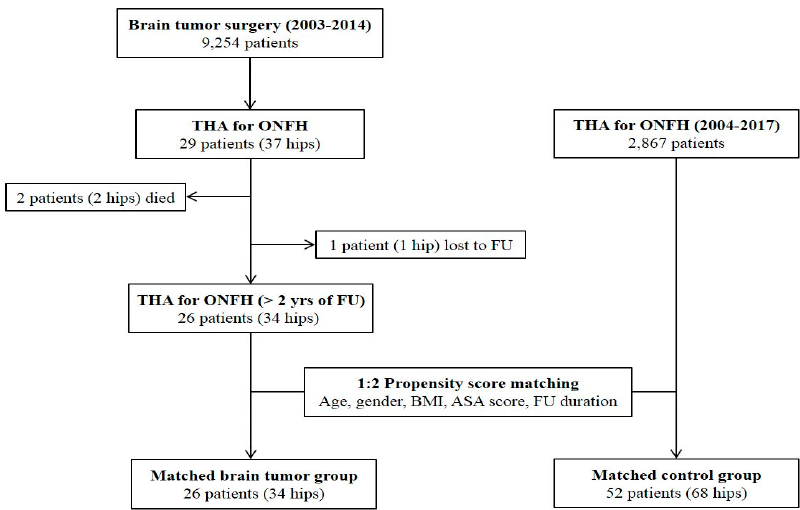
Figure 1. Patient flow diagram. THA, total hip arthroplasty; ONFH, osteonecrosis of the femoral head; FU, follow-up; BMI, body mass index; ASA, American Society of Anesthesiologists.